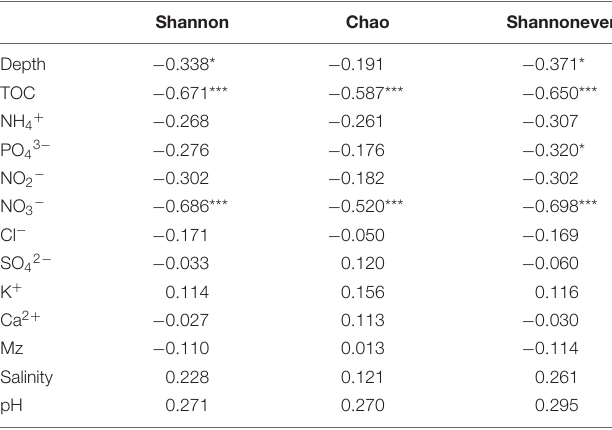
TABLE 4 | Correlations between environmental factors and microbial diversity